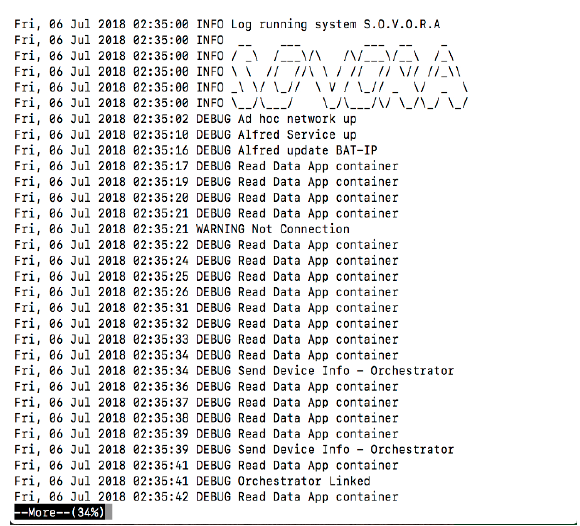
Figure 8. Orchestrator Info.